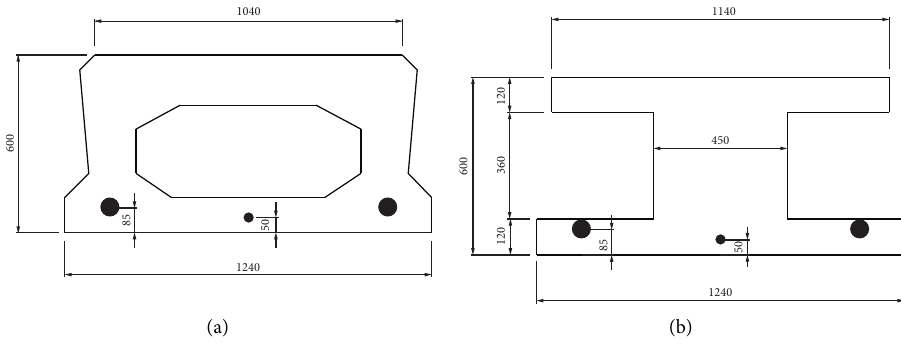
Figure 14: Equivalent conversion of midspan section. (a) Mid-span section of hollow slab. (b) I-section.